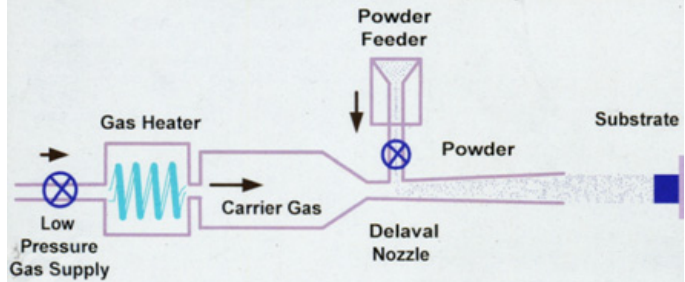
Figure 1: Operating principle of low-pressure coldspray [1].